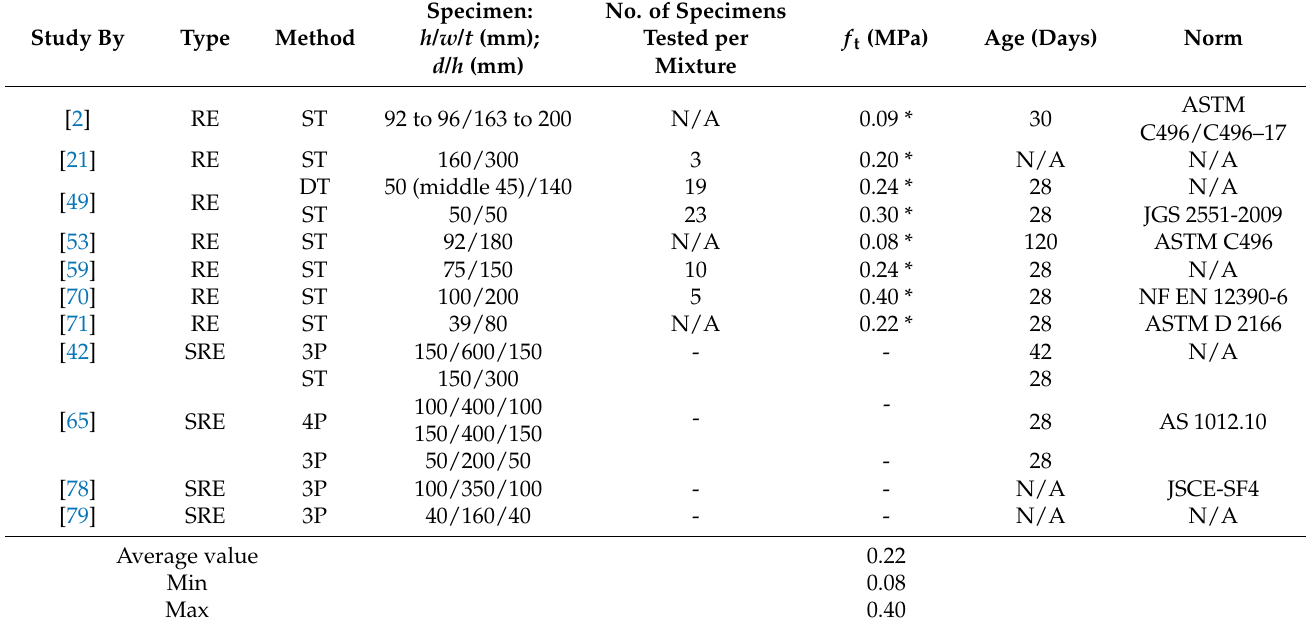
Table 5. Tensile strength values obtained at different age, with description of methods, specimens, and norms employed.